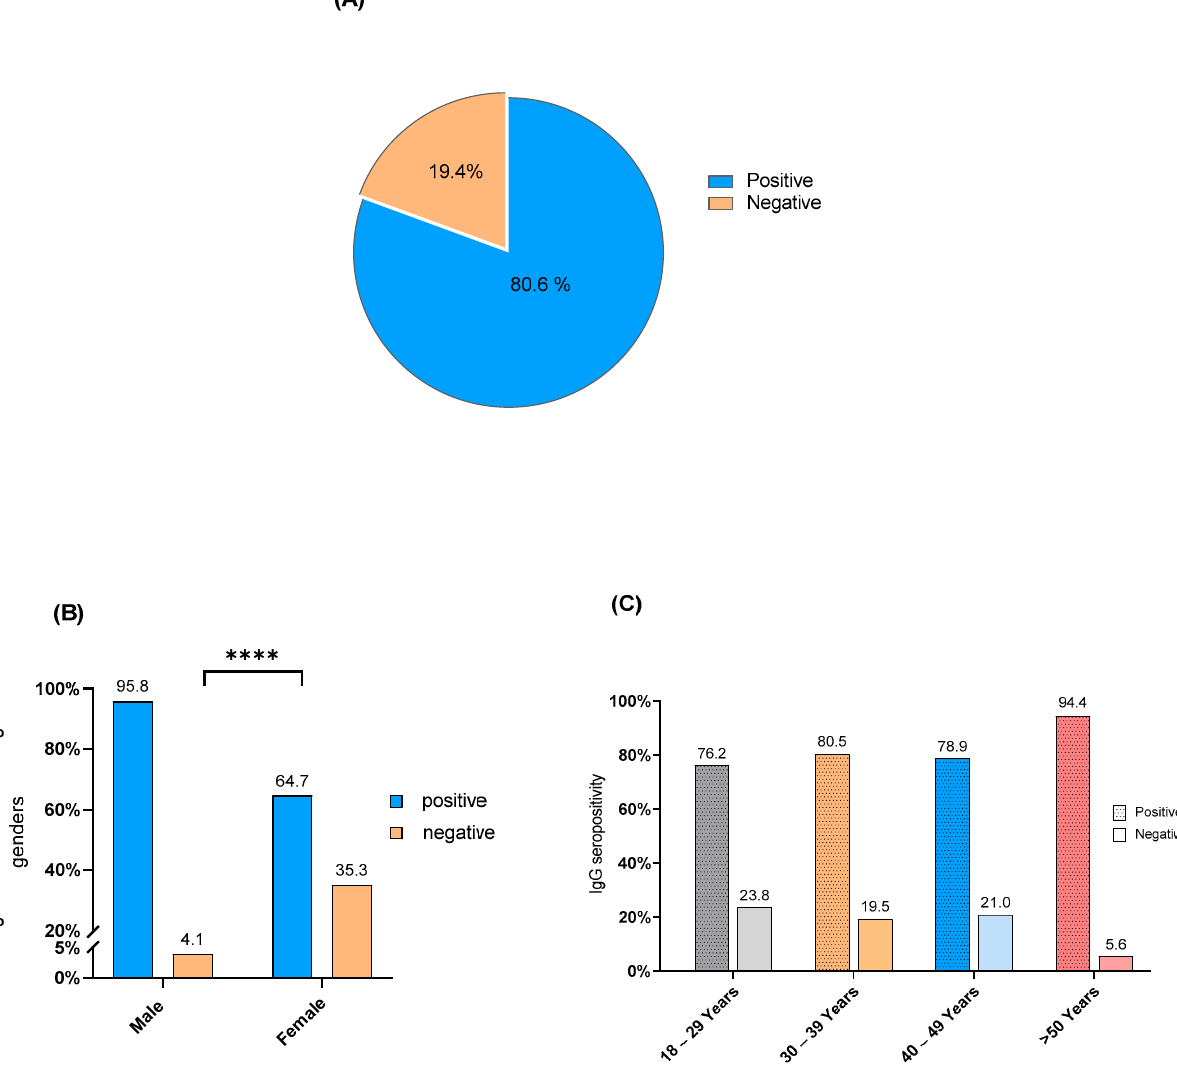
Figure 1. C. pneumoniae IgG seropositivity. ( A ) Seroprevalence in the sample population, ( B ) proportions of IgG seropositivity in different genders, ( C ) distribution of IgG seropositivity for different age groups. (****) p -value < 0.0001.